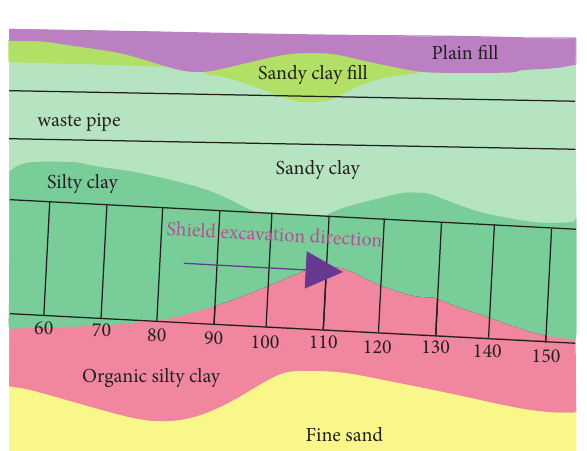
Figure 3: A-A section.